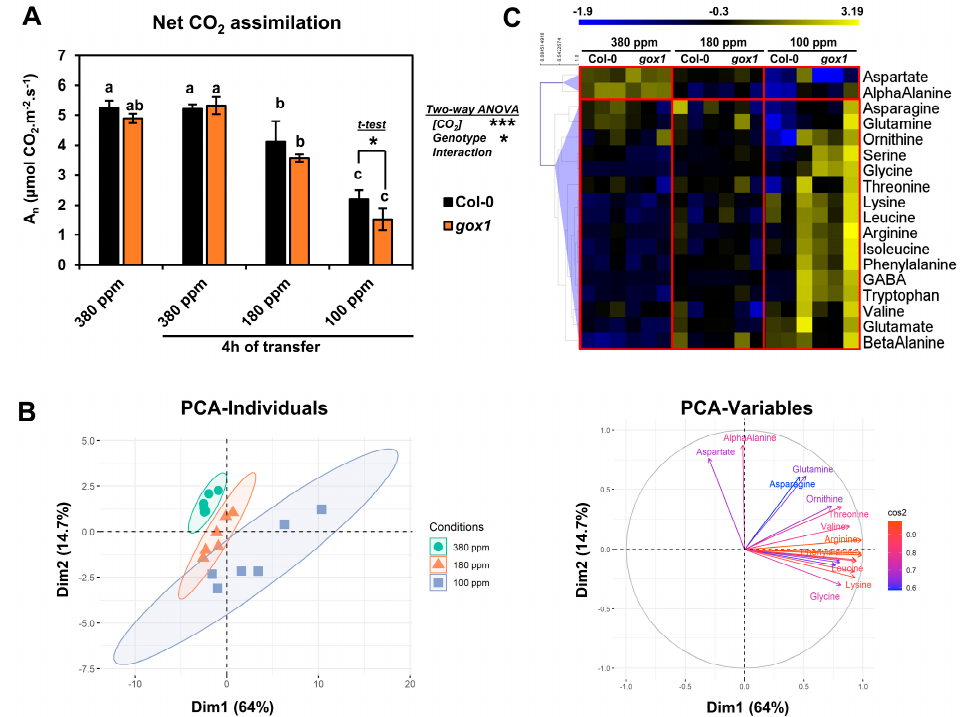
Figure 1. The effect of short-term low CO 2 treatments (180 and 100 ppm for 4 h) on net CO 2 assimilation rate and amino acid contents of Arabidopsis Col-0 and gox1 rosette leaves. ( A ) Net CO 2 assimilation rate before (380 ppm) and after exposure to an atmosphere with 380, 180 or 100 ppm CO 2 (4 h treatment). ( B ) Principal Component Analysis of amino acid contents of Col-0 and gox1 rosette leaves after a 4 h exposure to an atmosphere with 380, 180 or 100 ppm CO 2 . ( C ) Hierarchical clustering of amino acid contents based on Pearson’s correlation coefficients. Results are expressed as the mean ± standard deviation of three independent biological replicates. Different letters indicate groups of mean values that are significantly different between the conditions (two-way ANOVA test followed by a post-hoc Tukey HSD test, p -value < 0.05). Ellipses on the PCA plots represent the 95% confidence intervals. *** p -value < 0.001; * p -value < 0.05.